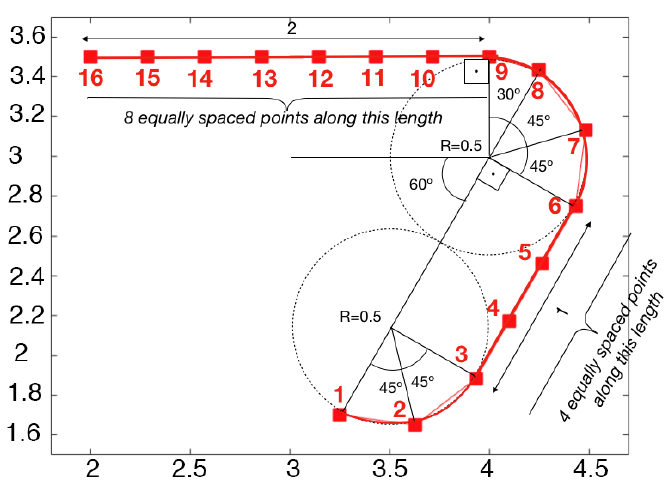
Figure 7. Example 1. Desired trajectory. Table 1. Example 1. Initial data.